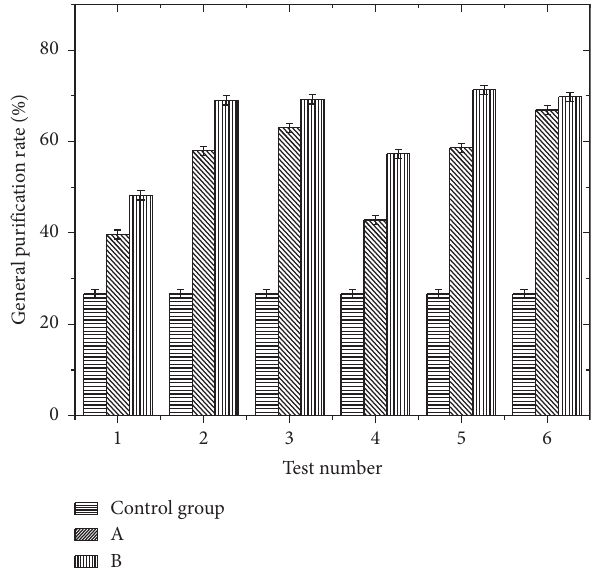
Figure 10: General purification effect of permeable concrete. Note: A-1 ∼ A-6: permeable concrete specimens with unmodified diato- mite and zeolite powder in different dosages; B-1 ∼ B-6: permeable concrete specimen with modified diatomite and zeolite powder in different